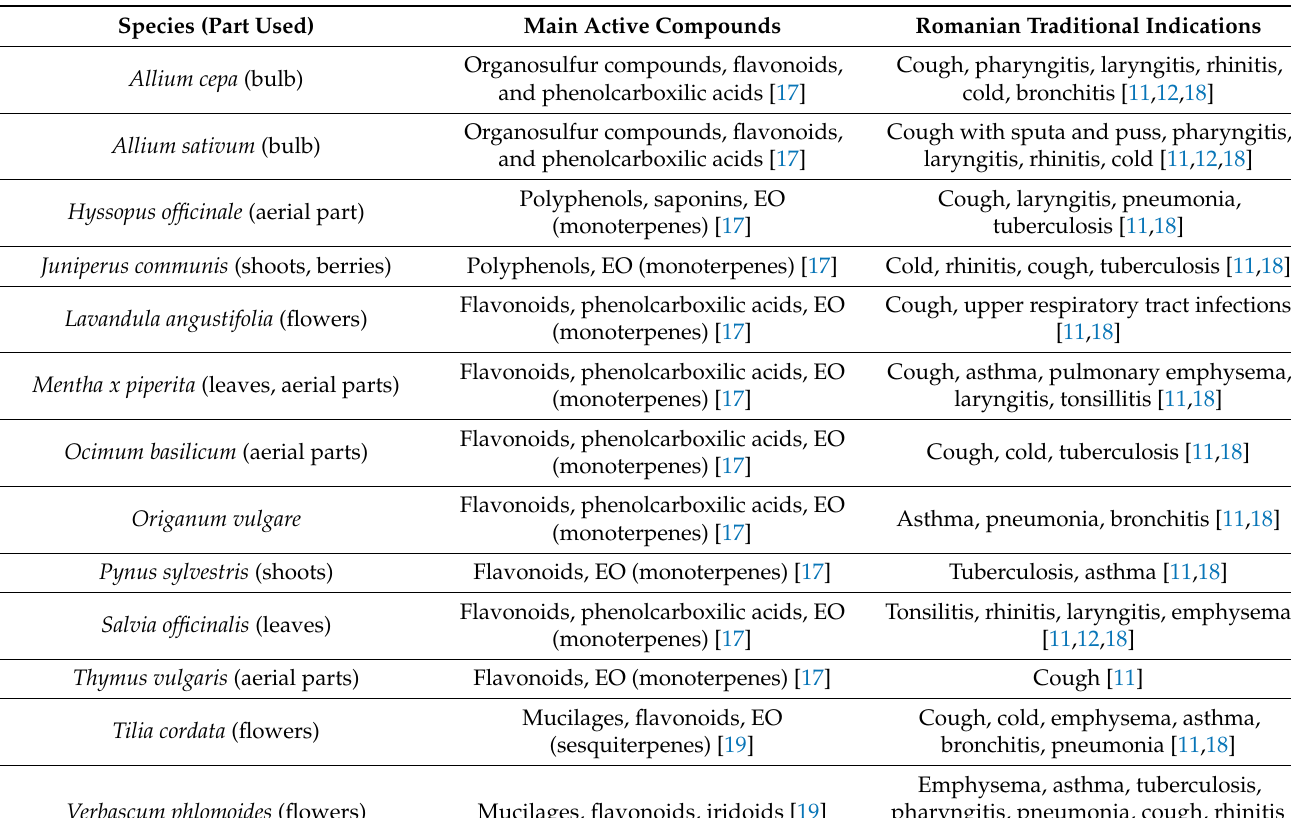
Table 1. Romanian folk medicines used in respiratory diseases and the main active